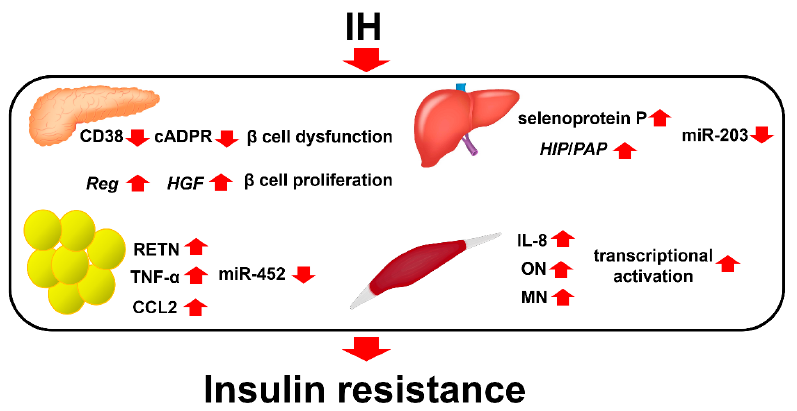
Figure 2. The relationship between IH and diabetes (insulin resistance). IH is involved in the reduction of glucose-induced insulin secretion from pancreatic β cells via downregulation of CD38 [5] and pancreatic β cell replication by the upregulation of Reg I and hepatocyte growth factor in pancreatic β cells [62]. IH also involves the upregulation of selenoprotein P and HIP/PAP in hepatocytes via downregulation of miR-203 [17]; upregulation of adipokines such as CCL2, TNF- α , and RETN in adipocytes via downregulation of miR-452 [64]; and upregulation of myokines such as IL-8, osteonectin, and myonectin in skeletal muscle cells [65–67], all of which can contribute to insulin resistance, glucose intolerance, and obesity [69].